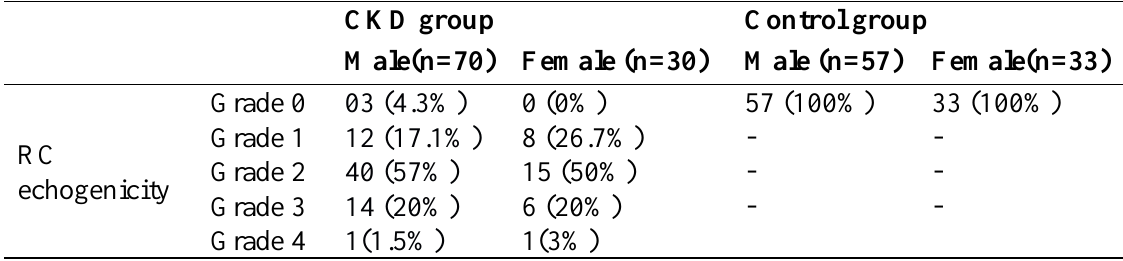
CKD - chronic kidney disease, RC - renal